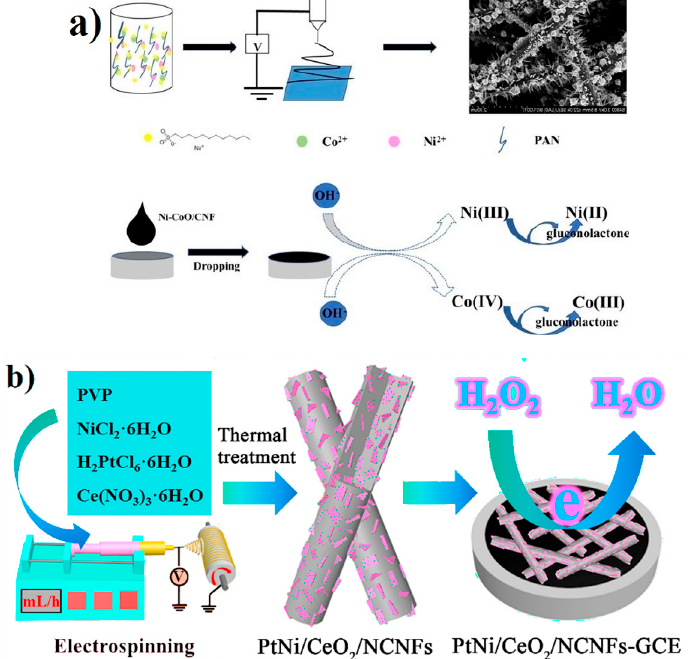
Figure 5. Electrospun NP interfaces for electrochemical sensors: ( a ) Experiment process and mechanism of carbon nanofibers (CNFs) loaded with nickel (Ni)/ cobaltous oxide (CoO) NPs [95], copyright 2019 Elsevier Ltd; ( b ) preparation and sensing principle of platinum-nickel alloy(PtNi)/ cerium oxide(CeO 2 )/n-doped carbon nanofibers(NCNFs) [63], copyright 2019 Elsevier Ltd.